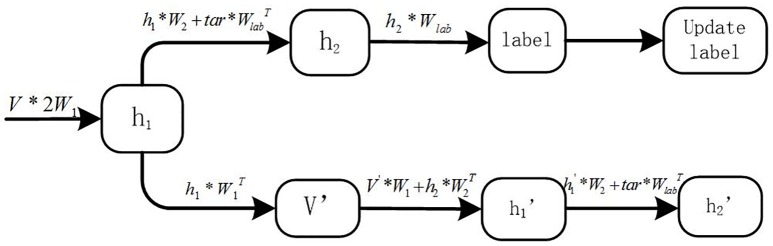
Training process.